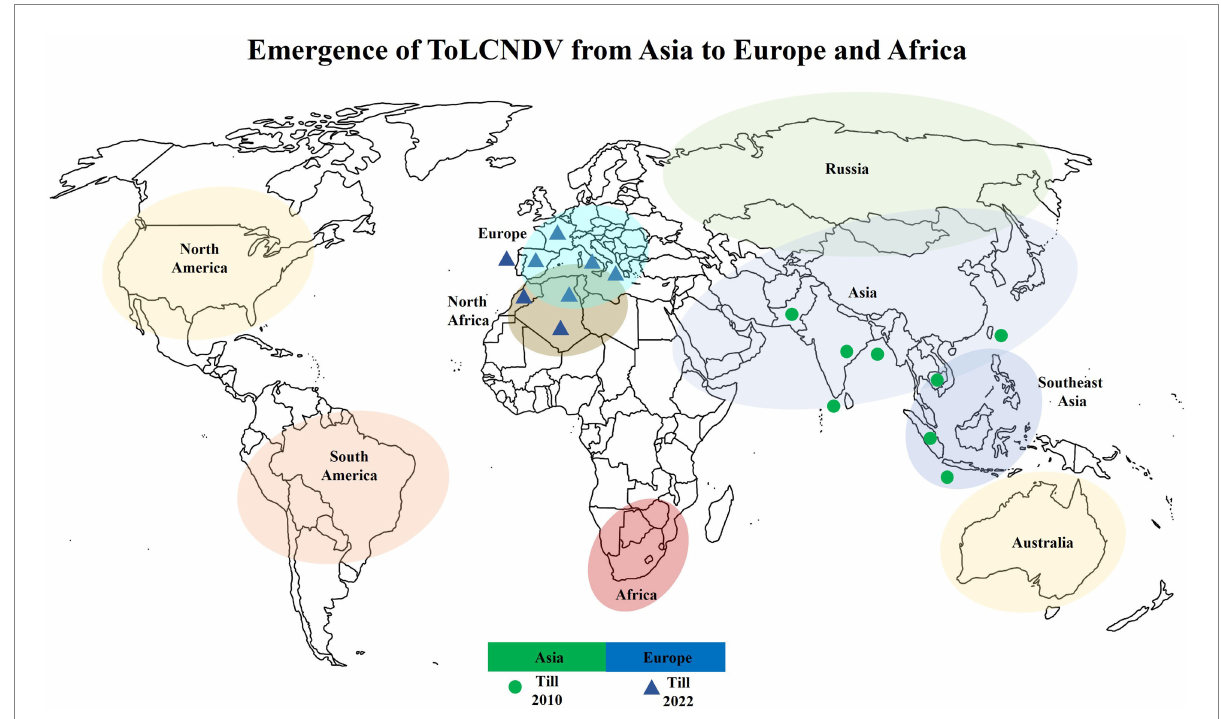
FIGURE 4 The emergence of ToLCNDV in Europe and Africa. Green dots indicate that infection was dominant in Southeast Asia until 2010. Blue triangles indicate the invasion of ToLCNDV in Europe and North Africa after